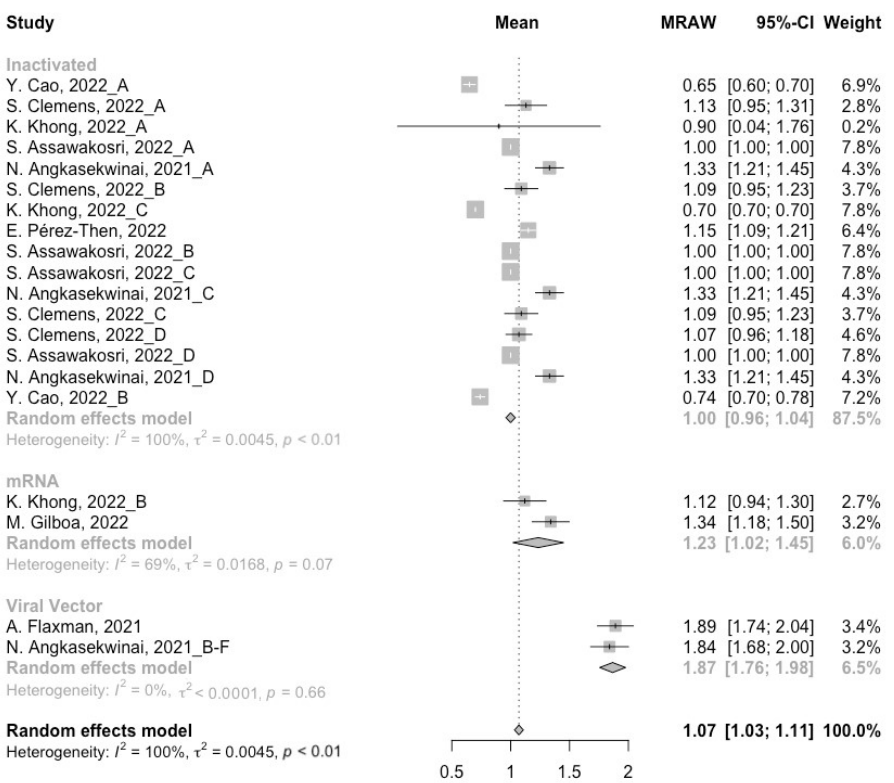
Figure 4. Forest plot of the pooled log-transformed neutralization titers against the Delta variant before booster vaccination.